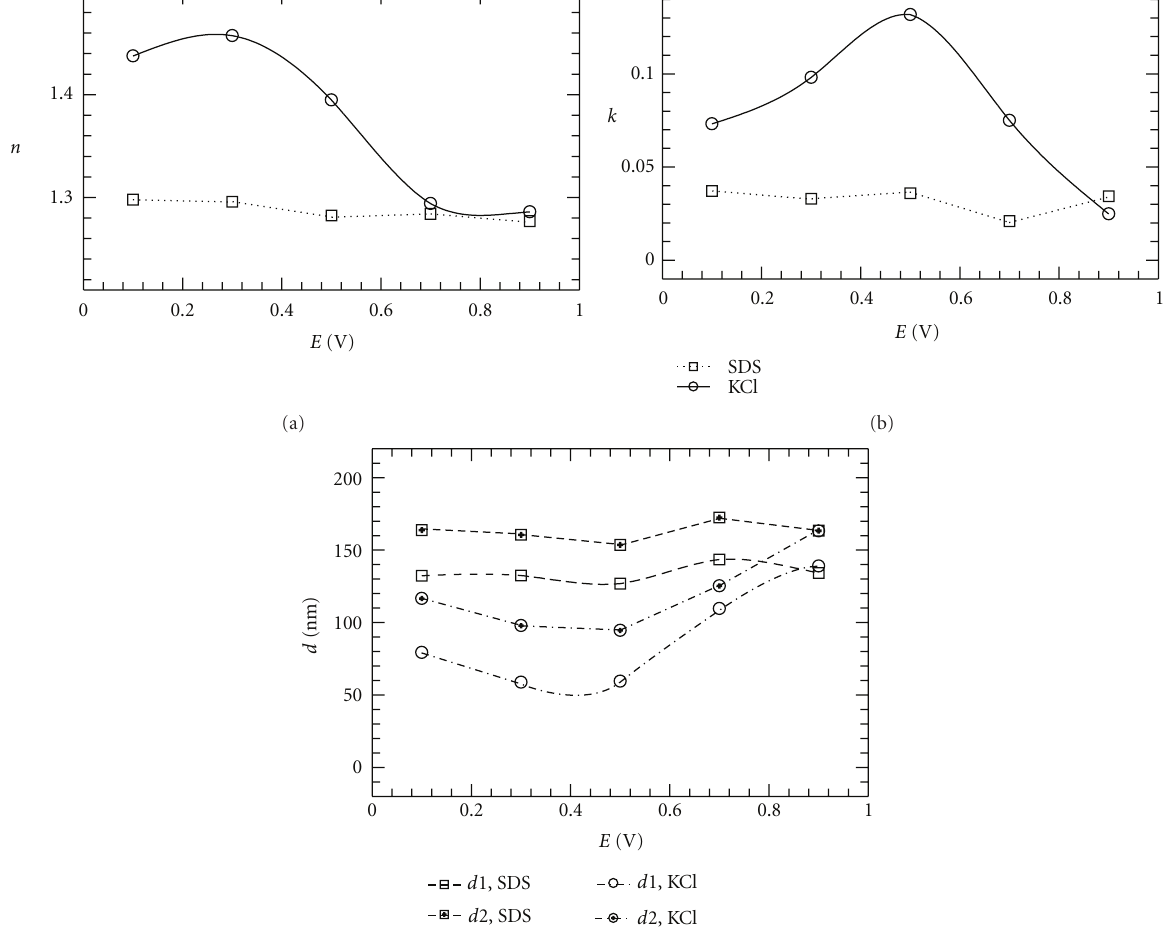
reduction. The higher values of n at 0.1 V correspond to the shrinking of the layer with exchange of cations and expulsion of